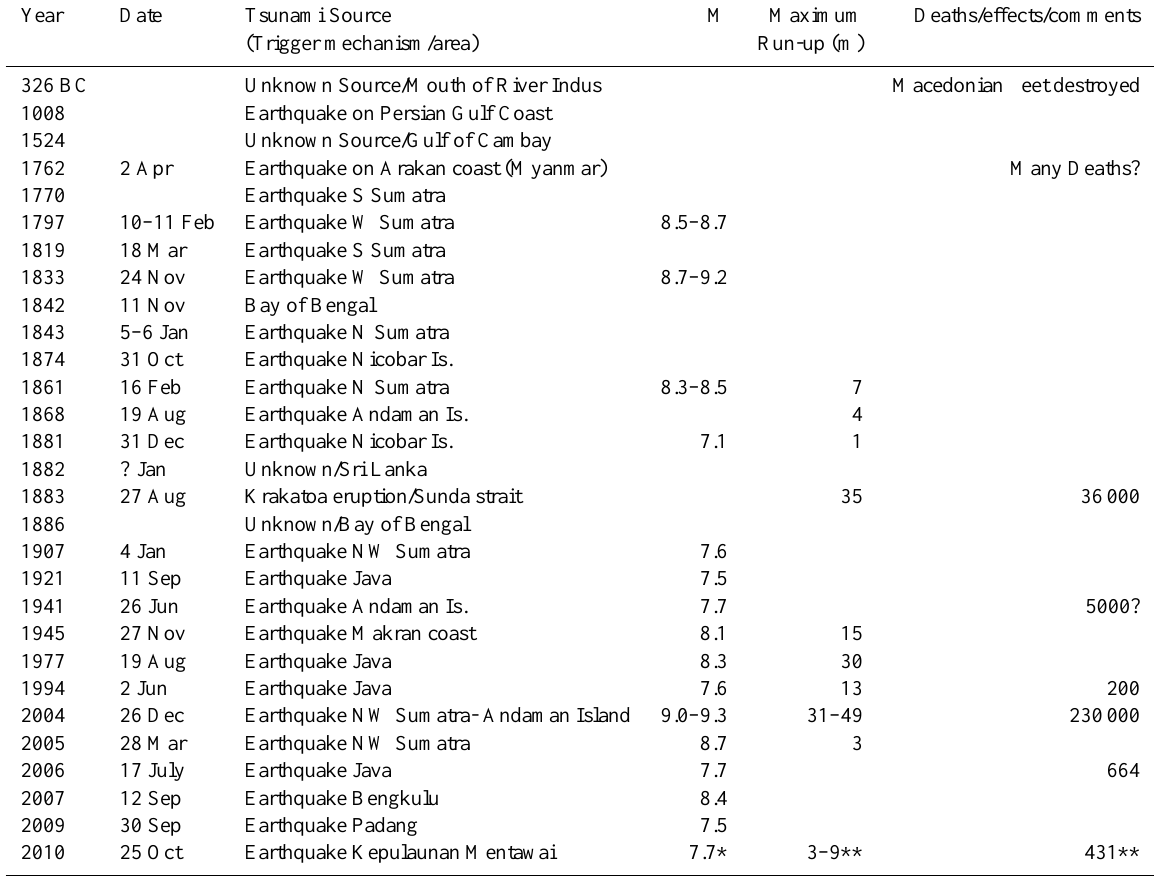
Table 2. List of historical tsunami records in the Indian Ocean (Dominey-Howes et al.,